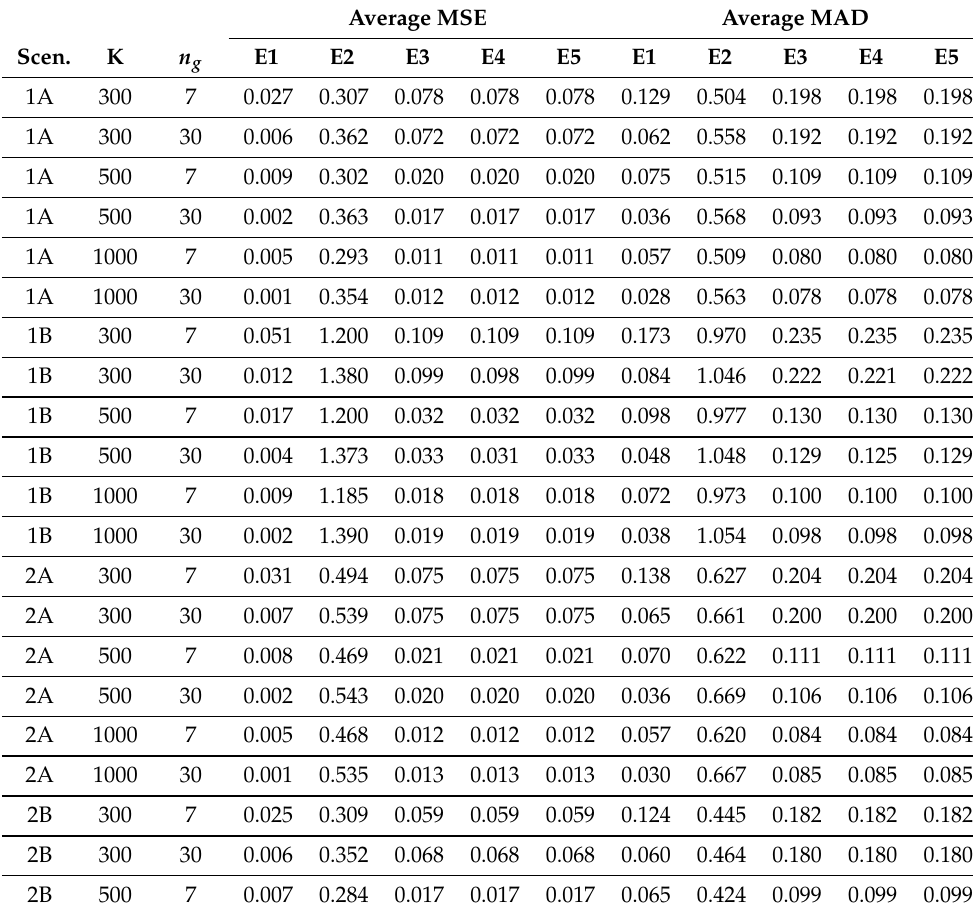
Table 2. Average MSE and MAD of Estimators E1 to E5 in Scenarios 1A to 3B. K is the sample size of the aggregate data. n g is the group size in the